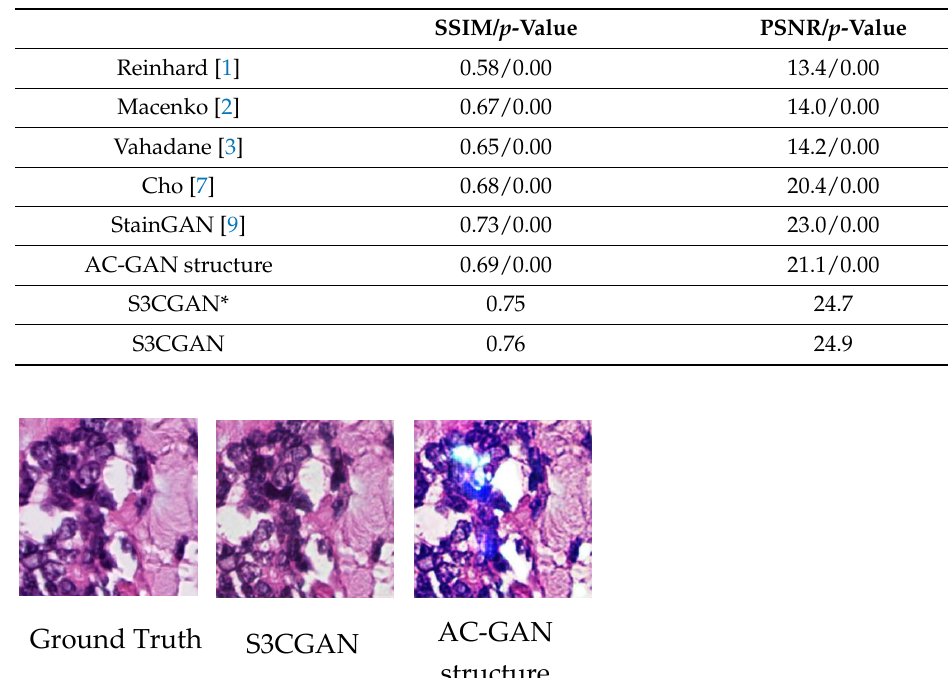
Table 2. Mean SSIM and mean PSNR values for different stain transfer methods.